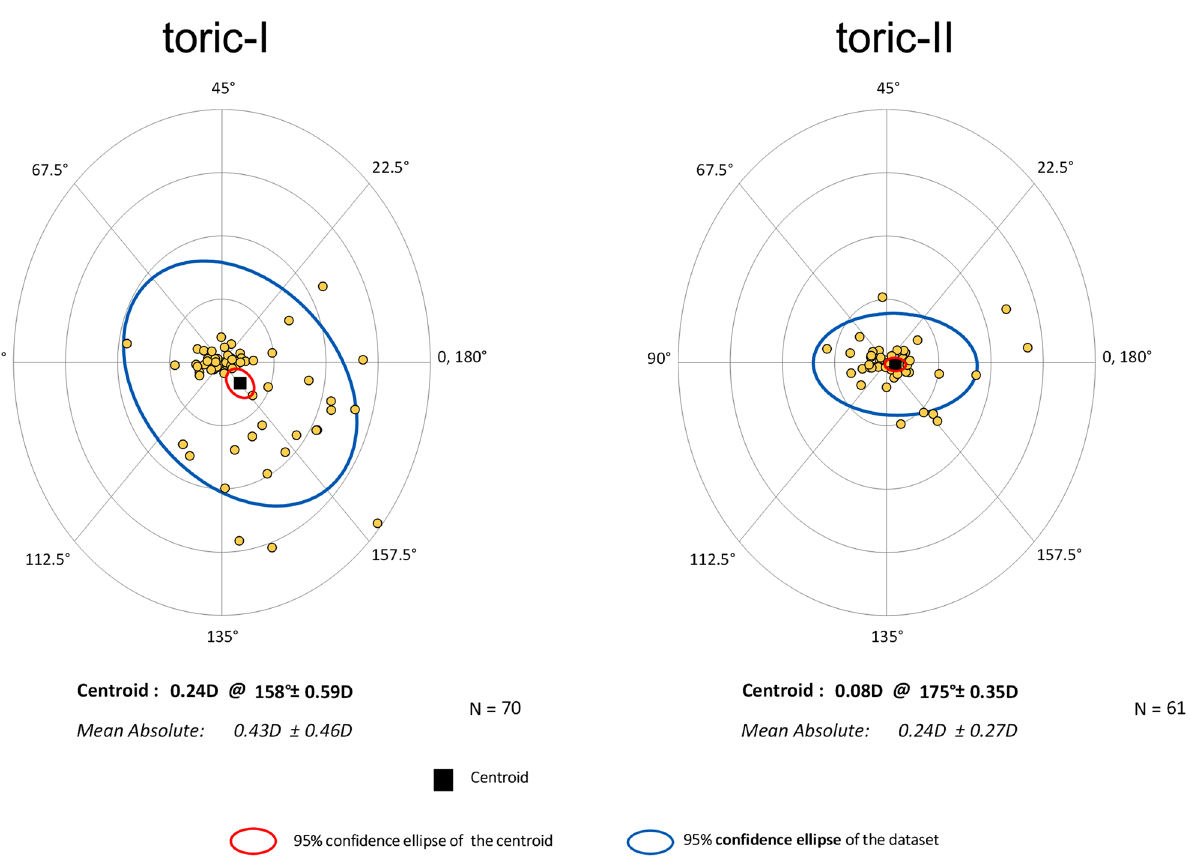
Figure 6. Double-angle plots of refractive astigmatism prediction errors evaluated with centroids, standard deviation of the centroids, and 95% confidence ellipses of the prediction errors. Prediction errors were smaller with toric-II than with toric-I IOLs. Each ring = 0.50 diopters